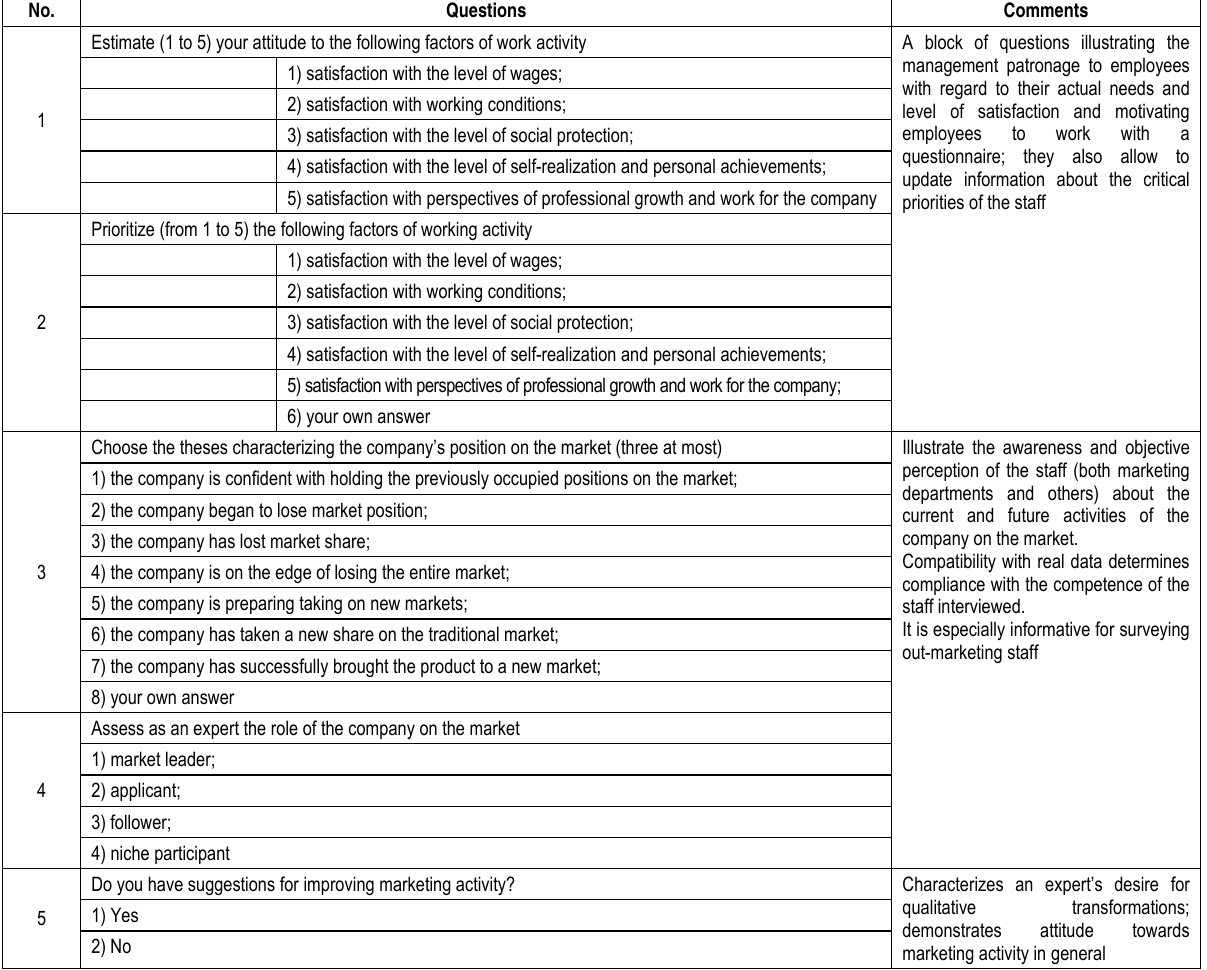
Table 3. Questionnaire as part of the staff analysis and selection during the reengineering of marketing activities